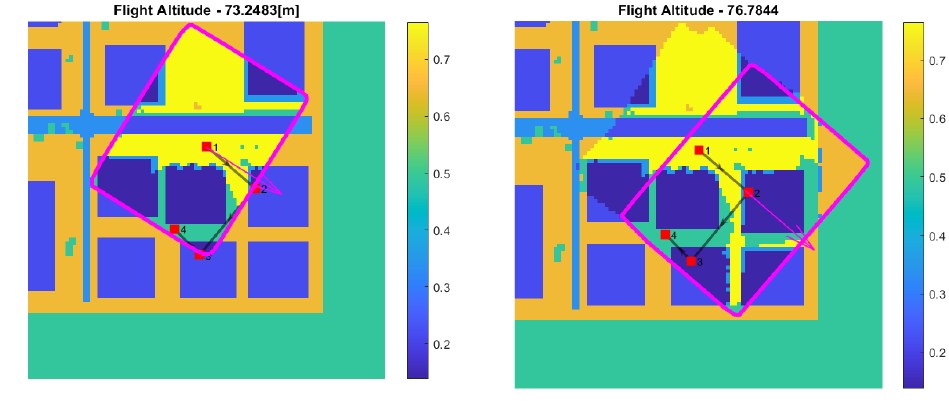
Figure 10. Bernoulli trial update: each cell is updated only once.